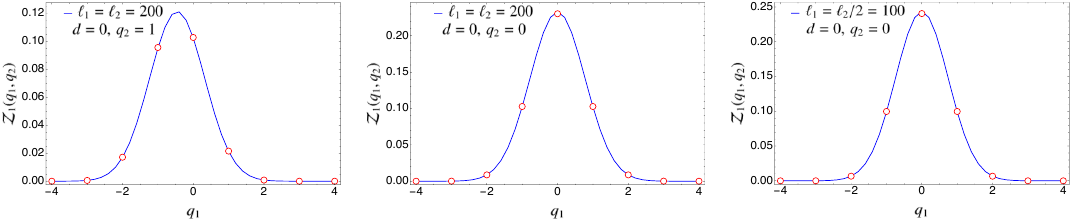
Figure 4 . Probability Z 1 ( q 1 , q 2 ) as a function of q 1 at fixed q 2 for two adjacent intervals of sizes ‘ 1 and ‘ 2 . The solid blue line is the theoretical prediction in eq.